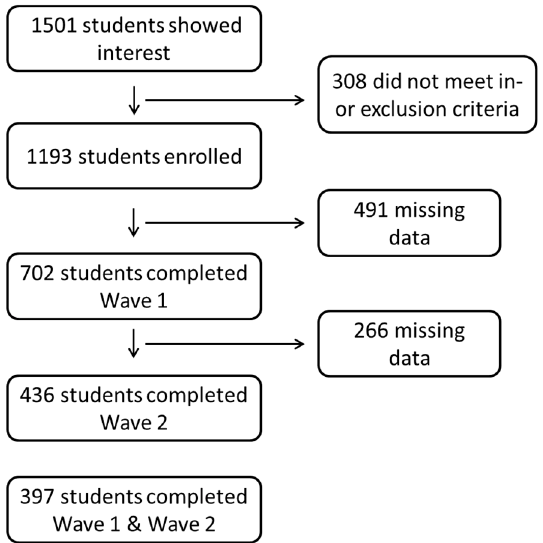
Figure 1. Student numbers throughout the study.